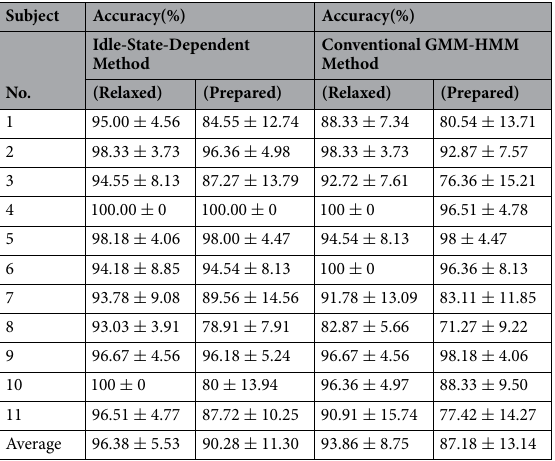
Table 2. Performance of motion prediction in different idle states. Accuracy is reported as mean standard deviation . Average accuracy rates are tested for statistical significance by Wilcoxon signed- ± rank test on the accuracy being higher with the idle-state-dependent method than with the conventional